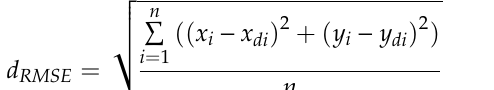
Figure 15. The root mean square error (RMSE) of the distances between the desired waypoints and